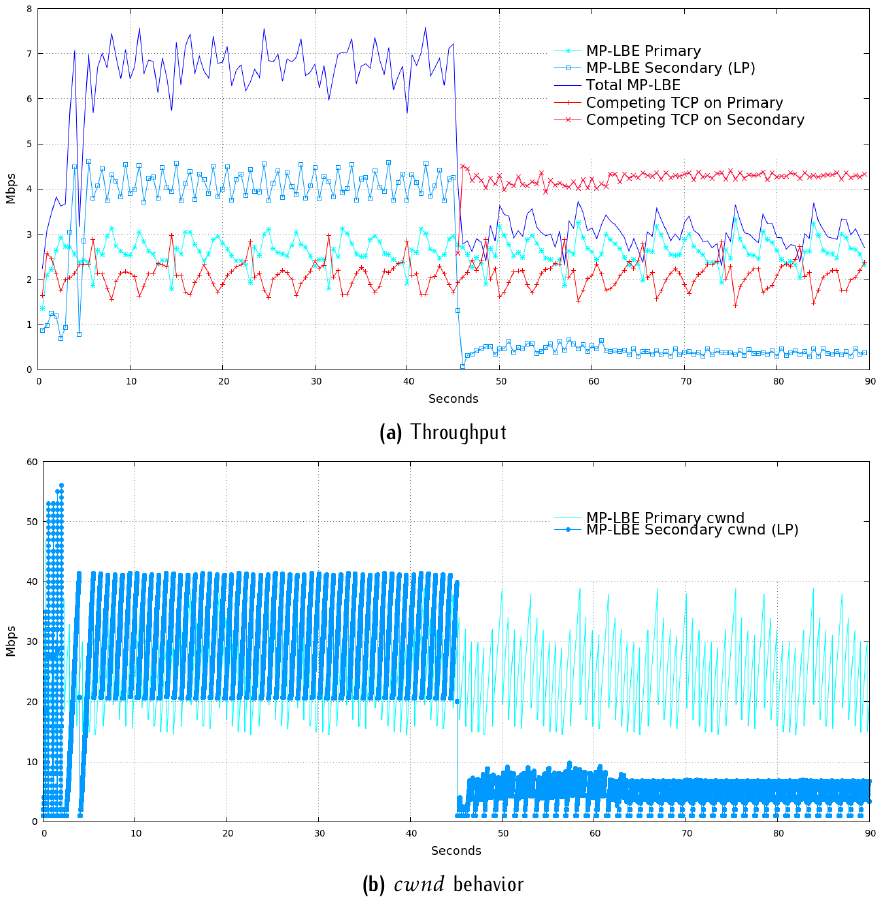
Figure 6. LBE Behavior of MP-LBE using